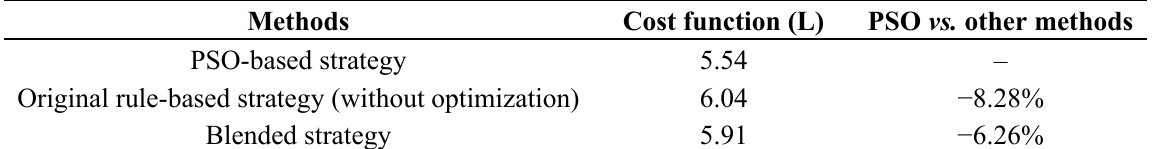
Figure 4. Simulation results based on the proposed strategy: ( A ) Velocity versus time; ( B ) Engine power versus time; ( C ) Battery power versus time; ( D ) Battery SoC versus time. Table 3. Optimization results in US06 driving